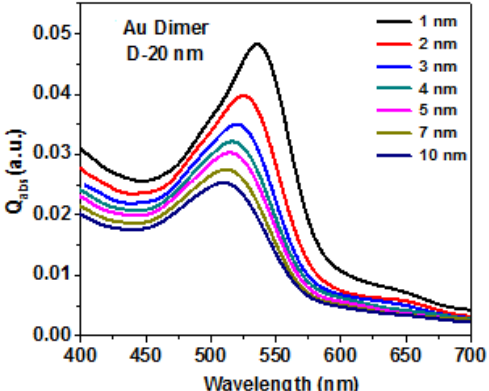
Figure 2: Absorption spectra of Au homo dimer nanostructure. The particle size is 20 nm and spacing is varied from 1 nm to 10